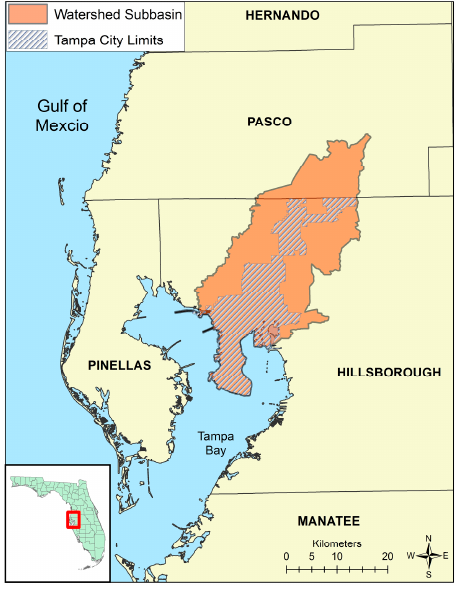
Figure 1. The study area subbasin, including the entirety of the City of Tampa, located inside the greater Tampa Bay Watershed, Florida, USA.